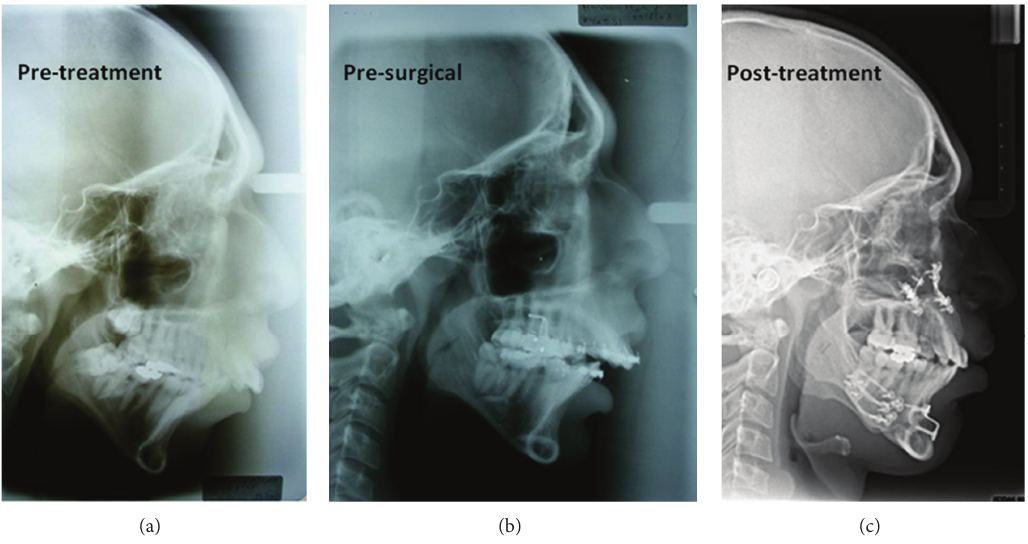
Figure 5: Pretreatment, presurgical and posttreatment lateral